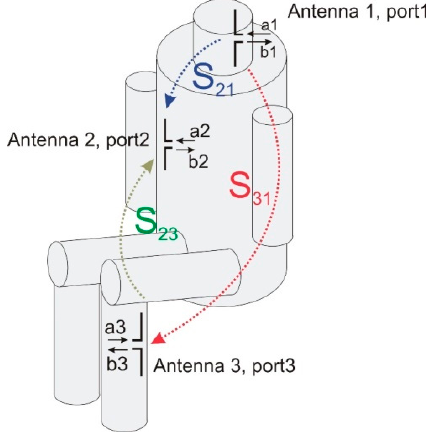
Figure 4. The scattering parameters defined with reference to the on-body antenna signals.